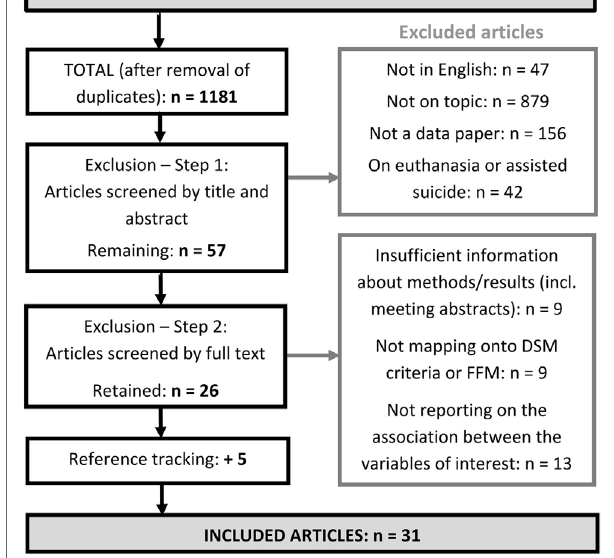
FigURe 1 | Flow diagram of the studies retrieved for the review. The key words under each descriptor were separated by “OR” for the search. On PubMed, corresponding MeSH terms were added to each descriptor field: Personality, Personality Disorders, Human Characteristics and Impulsive Behavior to Descriptor 1; Suicide to Descriptor 2, and Aged to Descriptor 3. Abbreviation: FFM, Five-Factor